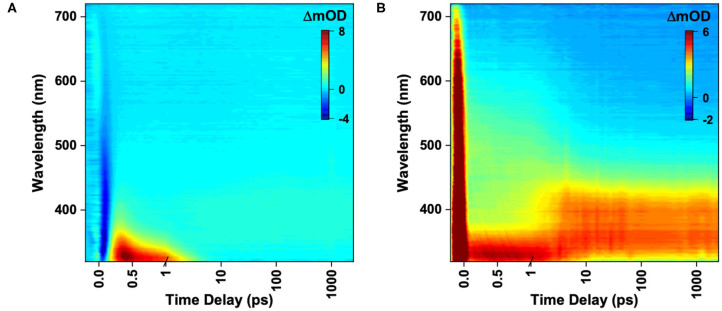
TEA spectra represented as false color maps of 4 mM ACyO in (A) EtOH photoexcited at 285 nm and (B) DMSO photoexcited at 280 nm. For (A,B) the time delays are plotted linearly until 1 ps and then as a log scale from 1 to 2,500 ps.